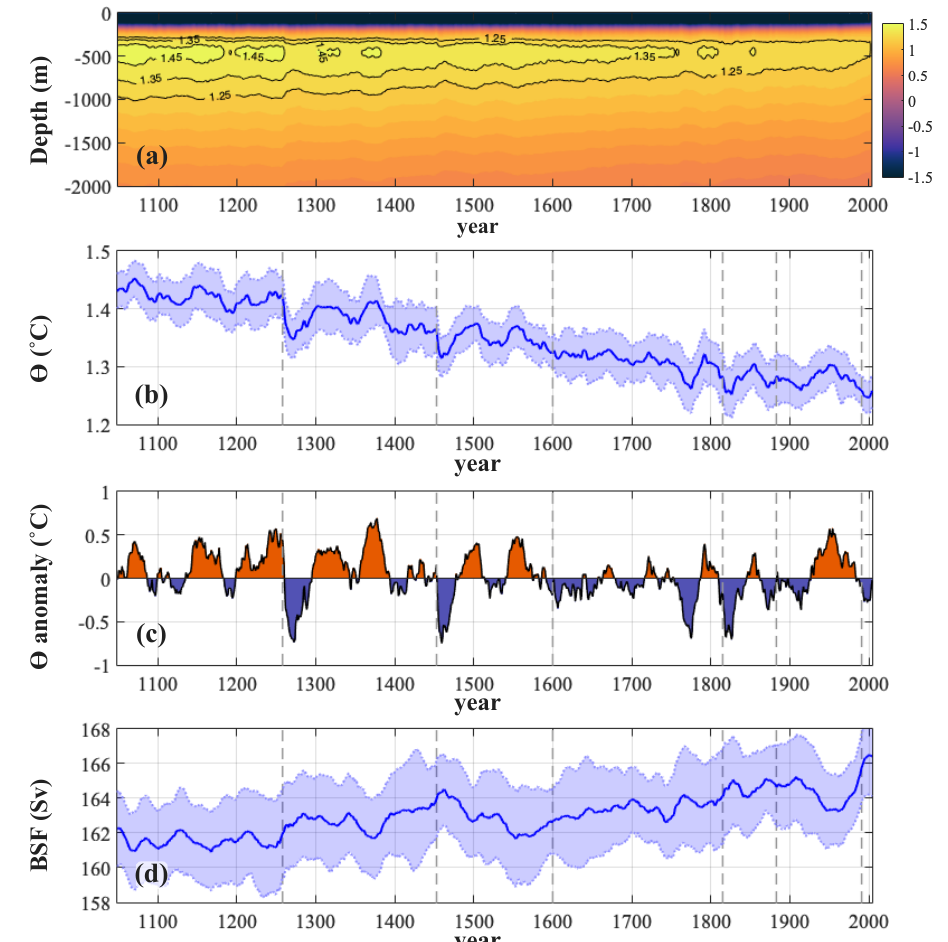
Figure 5. ( a ) Temporal variation throughout the simulation period (1050–2006) of the zonally averaged potential temperature of the WS transect between the surface and 2000m, encompassing the WDW domain. The isotherms of 1.25 ◦ C, 1.35 ◦ C and 1.45 ◦ C are marked by solid black lines to highlight the changes in the WDW core temperature. ( b ) Variation of the WDW core potential temperature defined as the 30% warmest grid points in the WS transect ( > 70th percentile of θ ). The solid blue line and the light blue shaded area represent the ensemble mean and the 13–member spread, respectively. ( c ) WDW core potential temperature detrended anomalies throughout the simulation period. ( d ) Variation of the barotropic streamfunction (Sv) of the southern limb of the WG. The solid blue line and the light blue shaded area represent the ensemble mean and the 13-member spread, respectively. Dashed gray lines mark major volcanic eruptions: Samalas, 1258; Kuwae, 1453; Huaynaputina, 1600; Tambora, 1815; Krakatoa, 1883; Pinatubo,